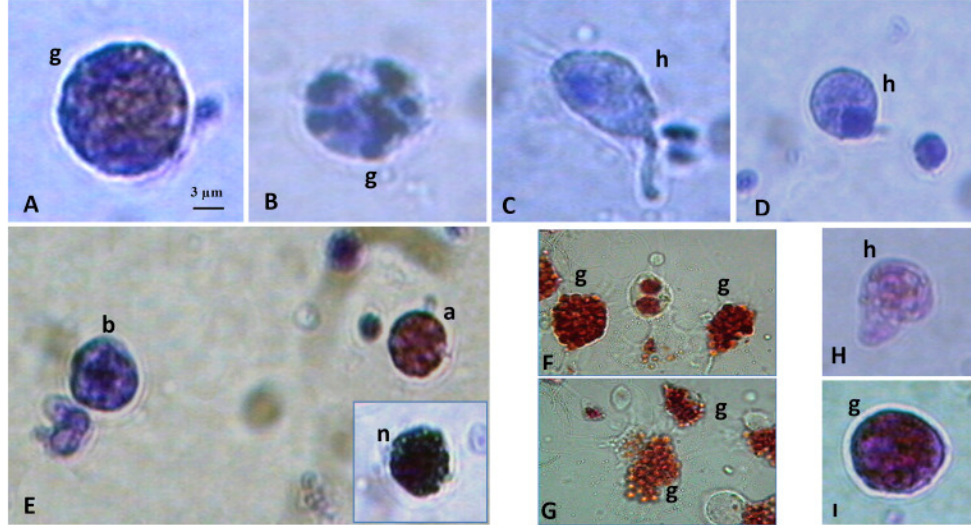
Figure 1. Pinna nobilis (bivalve) hemocytes under a light microscope (100×). ( A – D ): Giemsa staining; ( E ): Pappenheim’s panoptical and Ehrlich’s triacid mixture (inset) staining; ( F , G ): neutral red staining; and ( H , I ): PAS reaction. g: granulocyte; h: hyalinocyte; b: basophil; a: acidophil; and n: neutrophil [16].